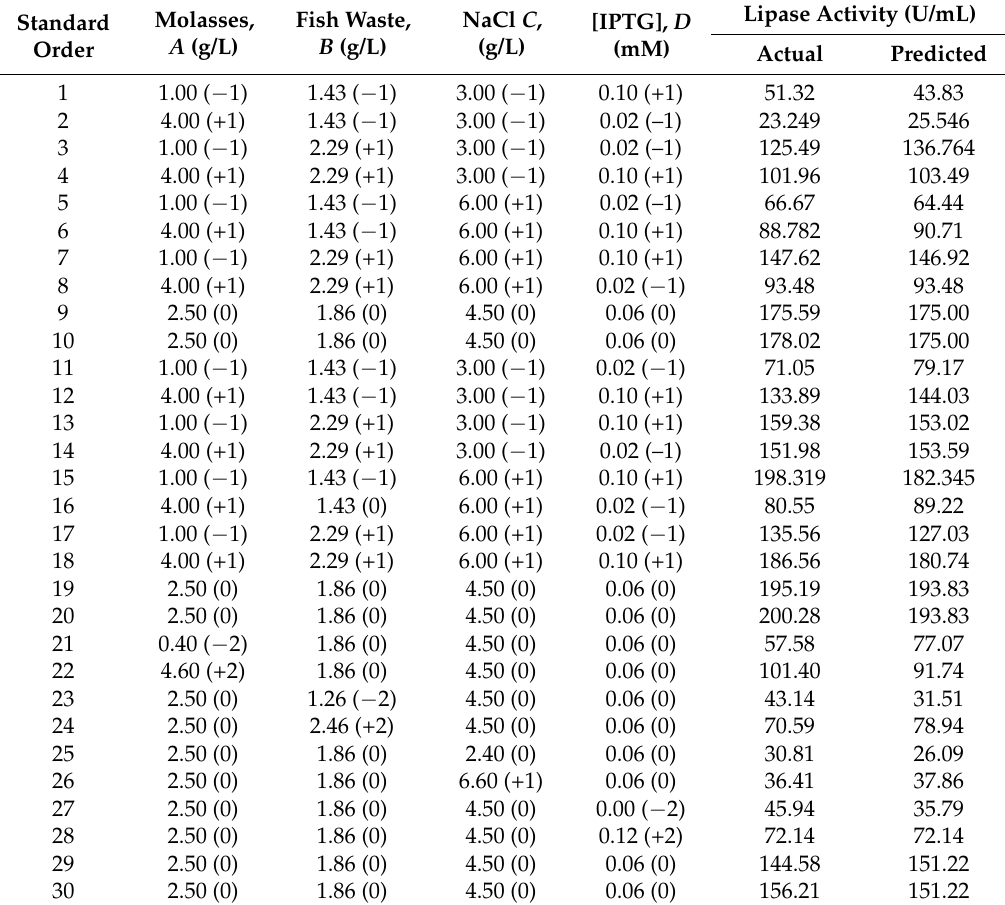
Table 4. Central Composite Rotatable Design of T1 Lipase